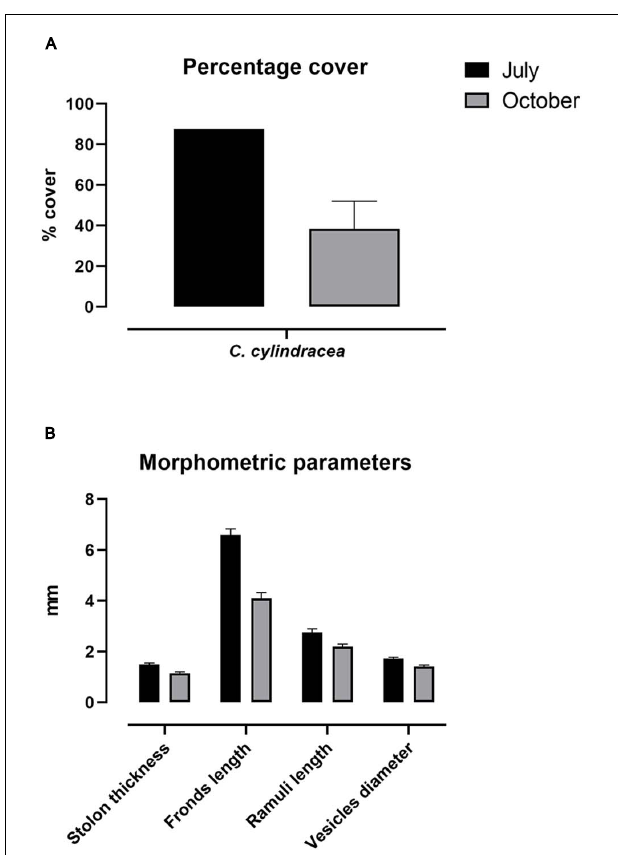
FIGURE 4 | Phenological parameters. Percentage cover (A) and phenology (B) of C. cylindracea sampled in July and October 2019. Morphological parameters are expressed as mean ±